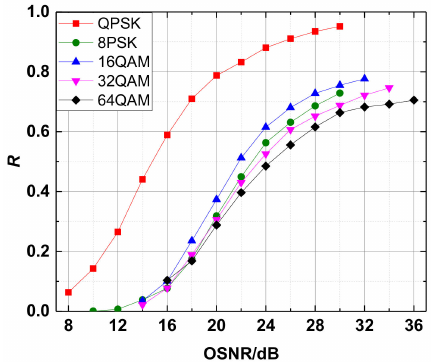
Figure 3. The value of R varies with di ff erent OSNR under five